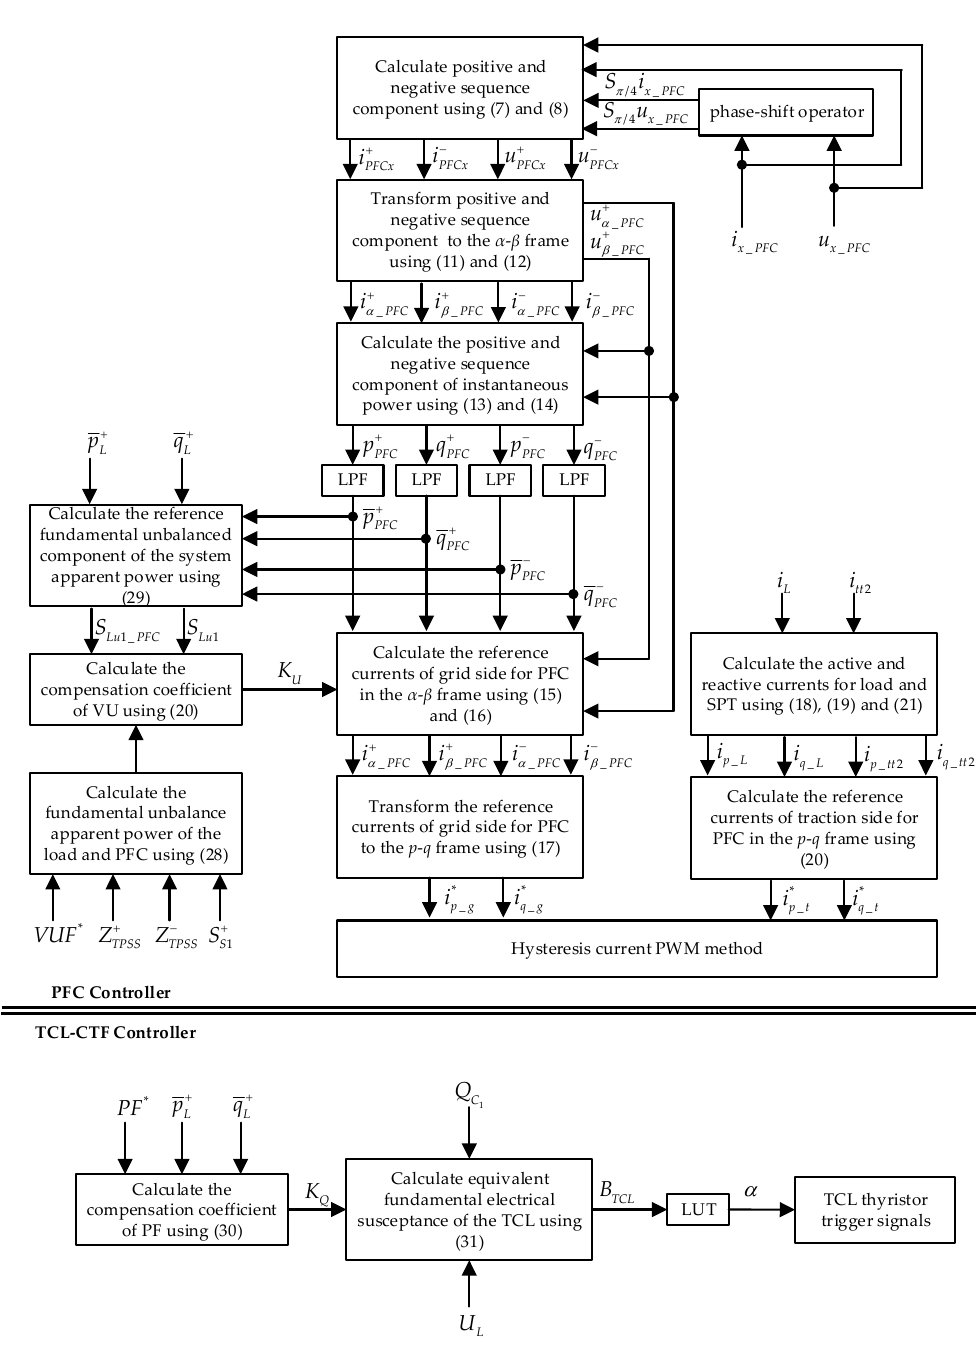
Figure 3. Control block of the optimized compensation strategy.